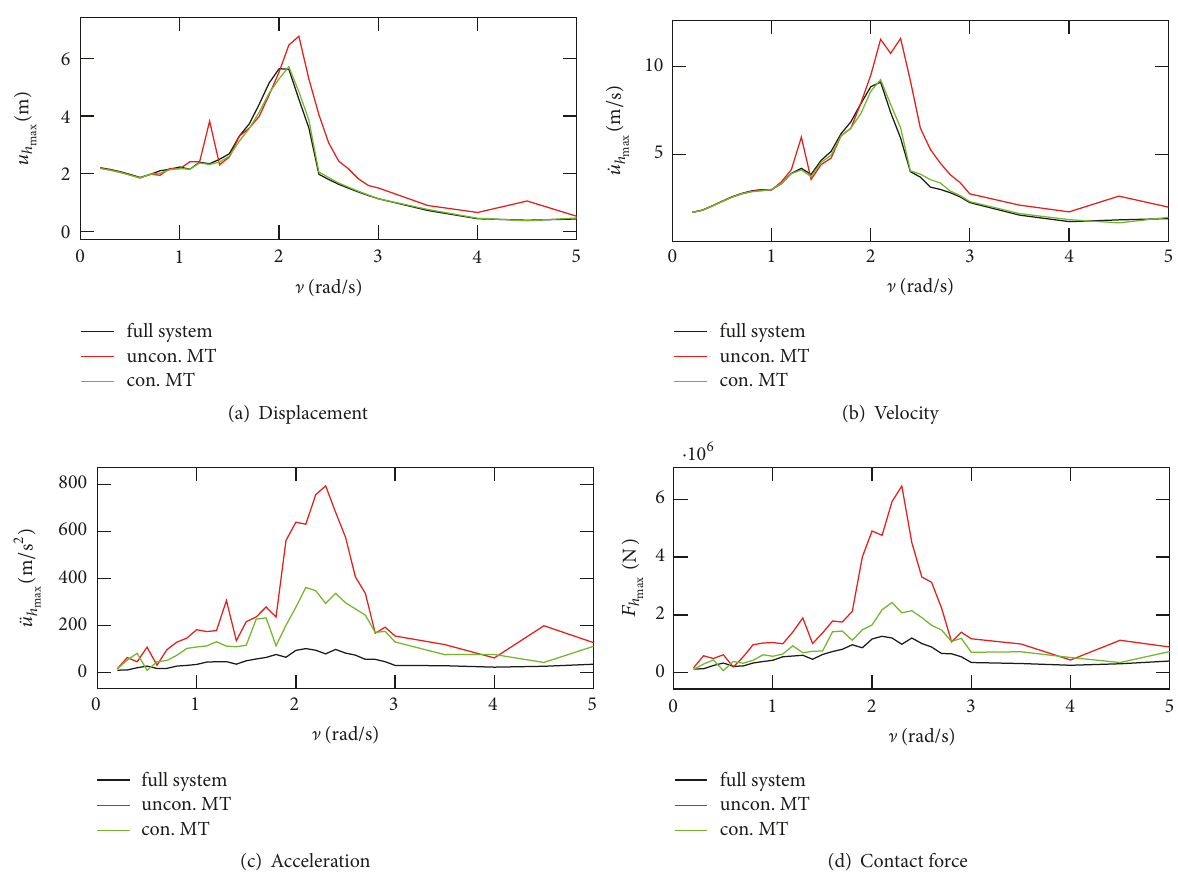
Figure 9: Frequency response of the maximum of the displacement, the velocity, and the acceleration as well as the contact force.